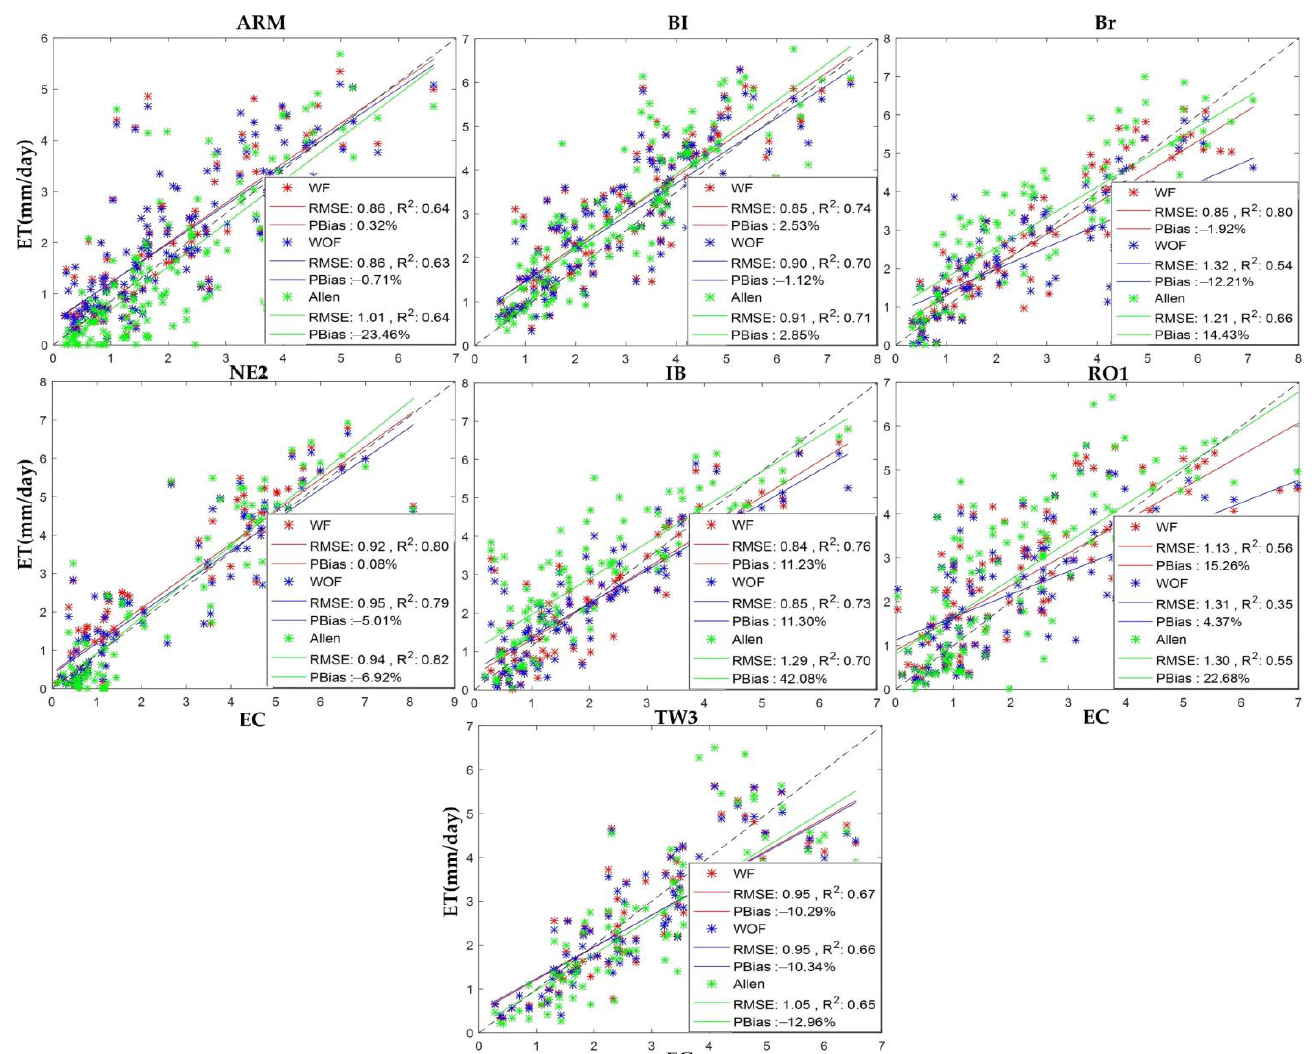
Figure 5. Daily actual ET estimated by the automated calibration methods vs. crop flux tower EC measurements.